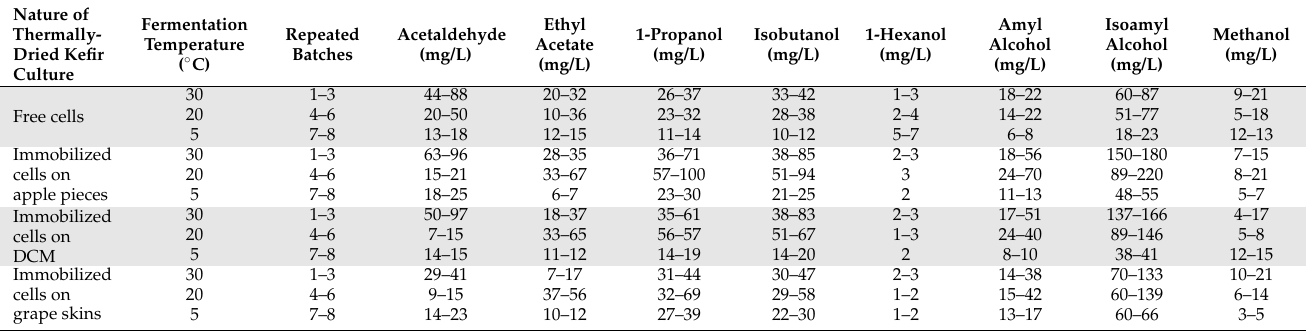
Table 4. Major volatiles of low alcohol wines fermented by repeated batch fermentations at